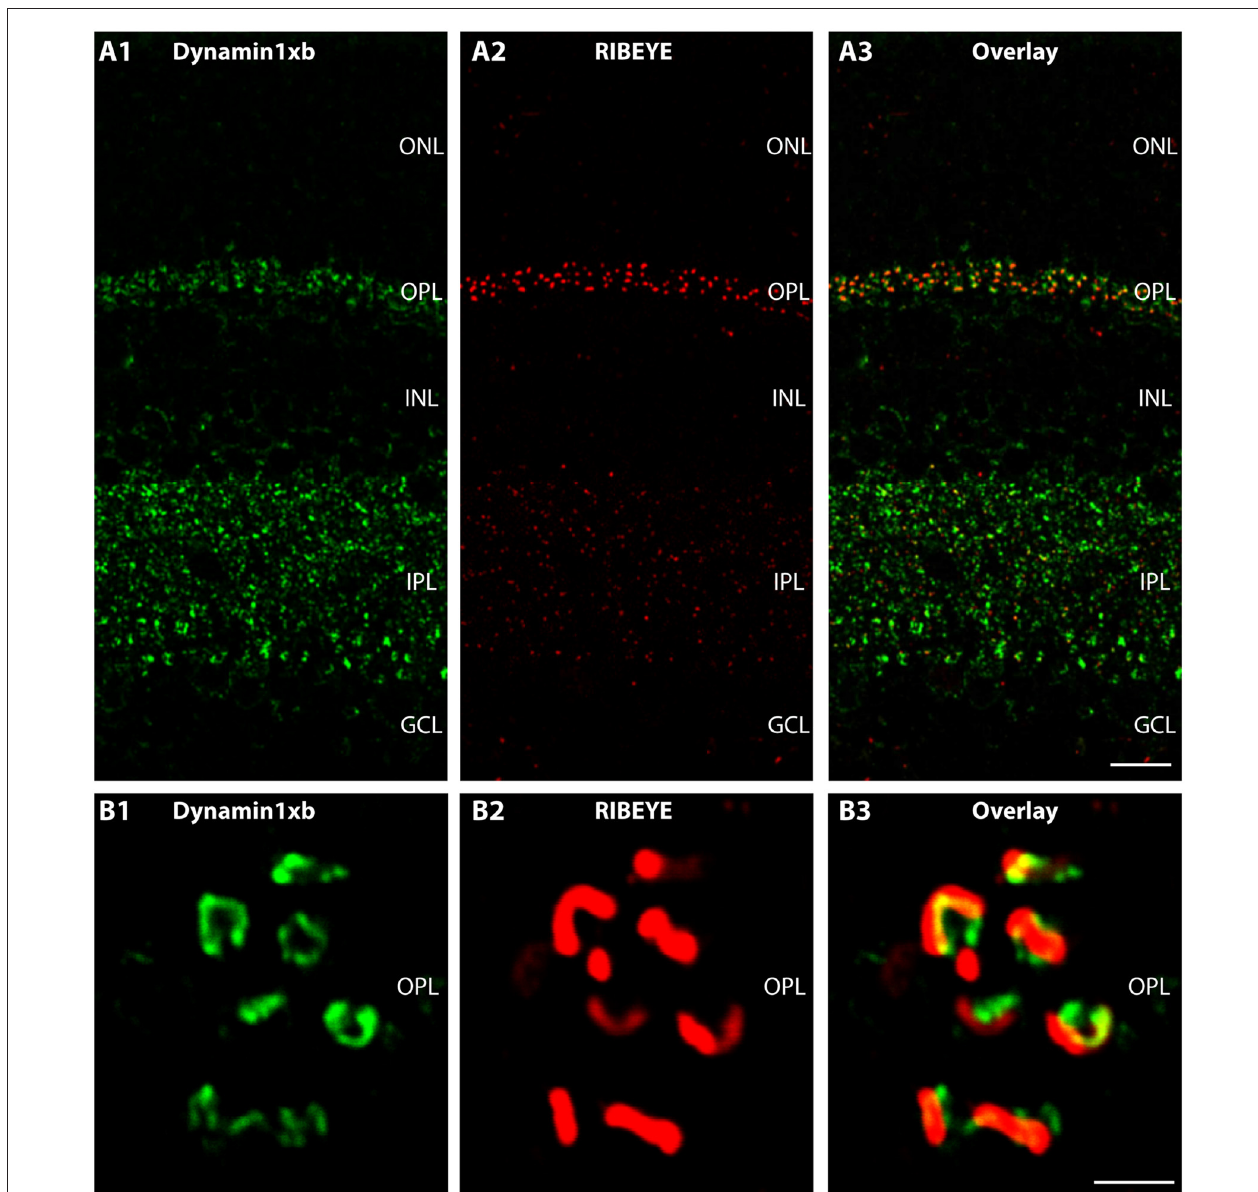
FIGURE 3 | Semi-thin (0.5 µ m-thin) sections of the mouse retina immunolabeled with the monoclonal antibody against dynamin1xb. Very predominantly, the synaptic layers of the retina, the OPL and the IPL were immunolabeled by the dynamin1xb antibody. The synaptic layers were visualized by double-immunolabeling with rabbit polyclonal antibodies against RIBEYE (U2656; Schmitz et al., 2000), a major component of synaptic ribbons. In the synaptic layers, the dynamin1xb signal was discrete and displayed a spot-like distribution at low magnification (A) . High-resolution confocal microscopy (B) of the dynamin1xb immunosignals in the OPL where photoreceptor ribbon synapses are located revealed that the dynamin1xb immunolabeling is highly enriched in close vicinity to the synaptic ribbon. The labeling pattern is very similar to the previously observed immunolabeling pattern with a dynamin antibody that did not discriminate between distinct splice